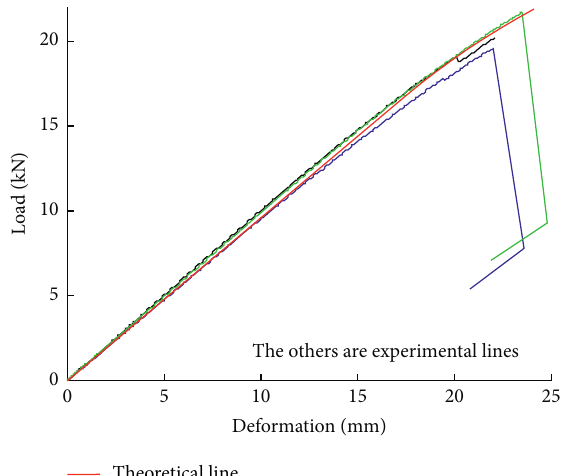
Figure 7: Comparison of the load-deflection curves of PSL beams obtained by test and